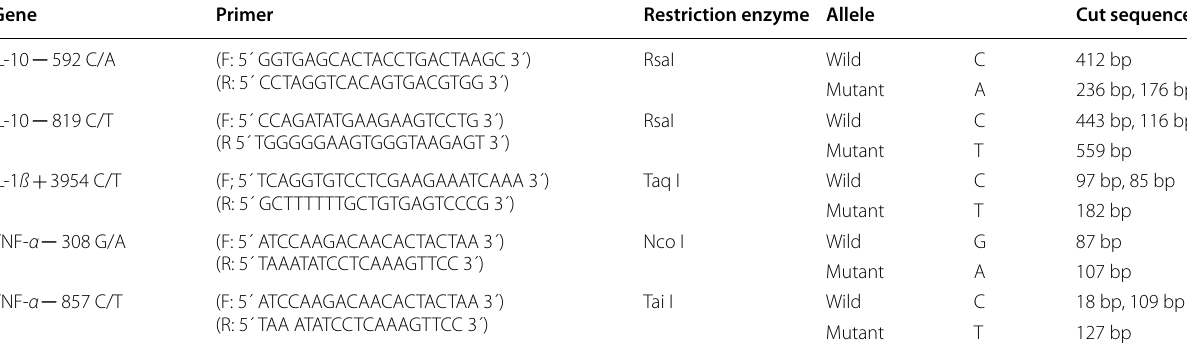
Table 1 Primer sequence, restriction enzyme, and cut sequences for each gene Gene